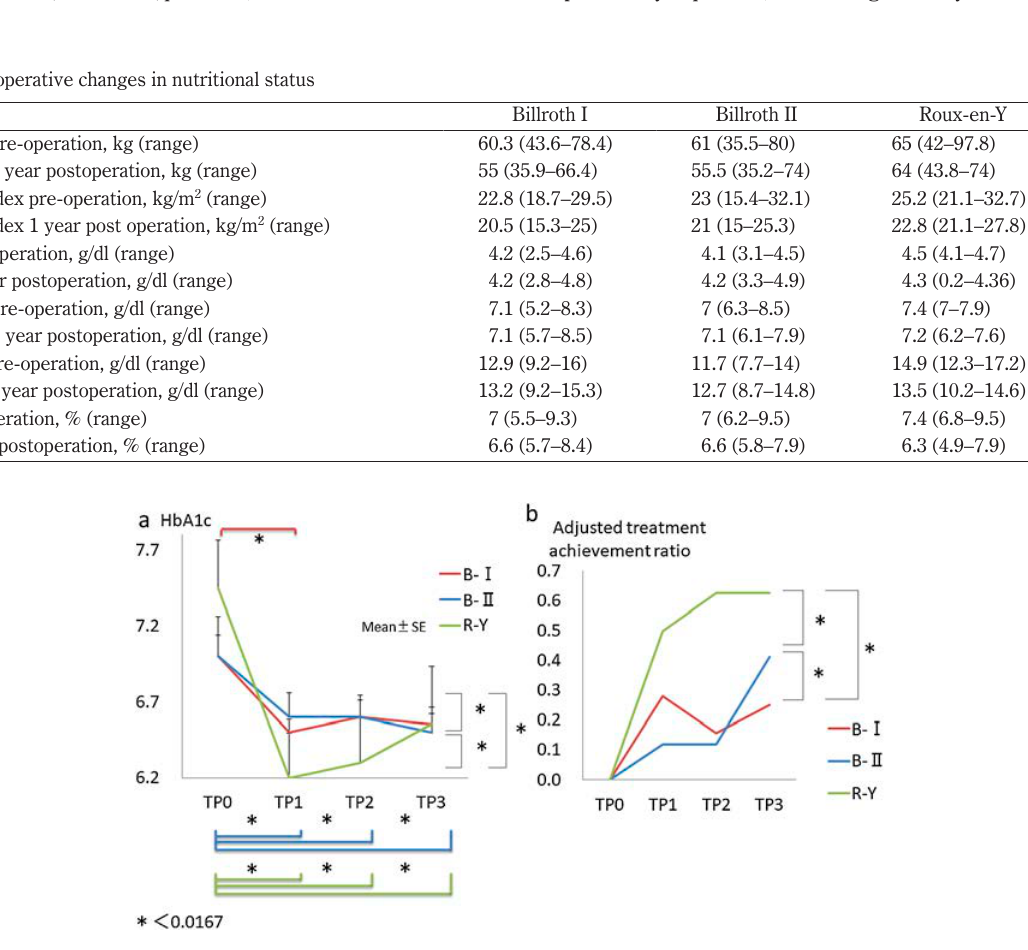
Figure 3 [a] HbA1c change (B-I vs. B-II vs. R-Y); and [b] adjusted treatment achievement ratio (B-I vs. B-II vs. R-Y). B-I, Billroth I; B-II, Billroth II; R-Y, Roux-en-Y; SE, standard error; TLDG, totally laparoscopic distal gastrectomy; TP0, within 1 month before surgery; TP1, from 1 to 3 months after surgery; TP2, from 6 to 12 months after surgery; TP3, from 24 to 36 months